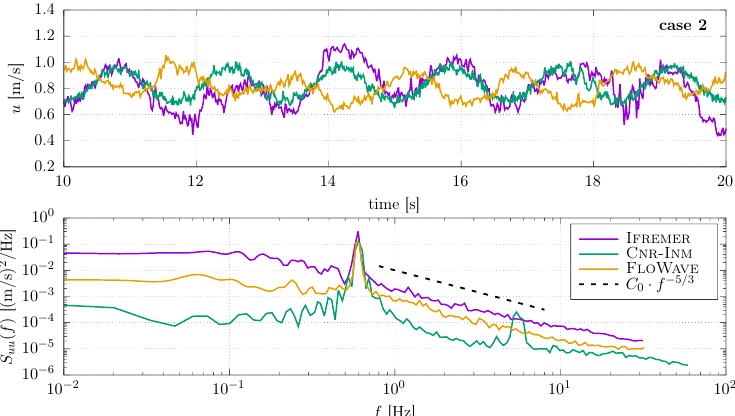
Figure 6. Time histories (top) of the ADV streamwise velocity u measured at the top-dead centre of the rotor for case 2 and their corresponding PSD (bottom) at I FREMER , F LO W AVE and C NR -I NM . The PSD panel also includes Kolmogorov’s 5/3 power law. −